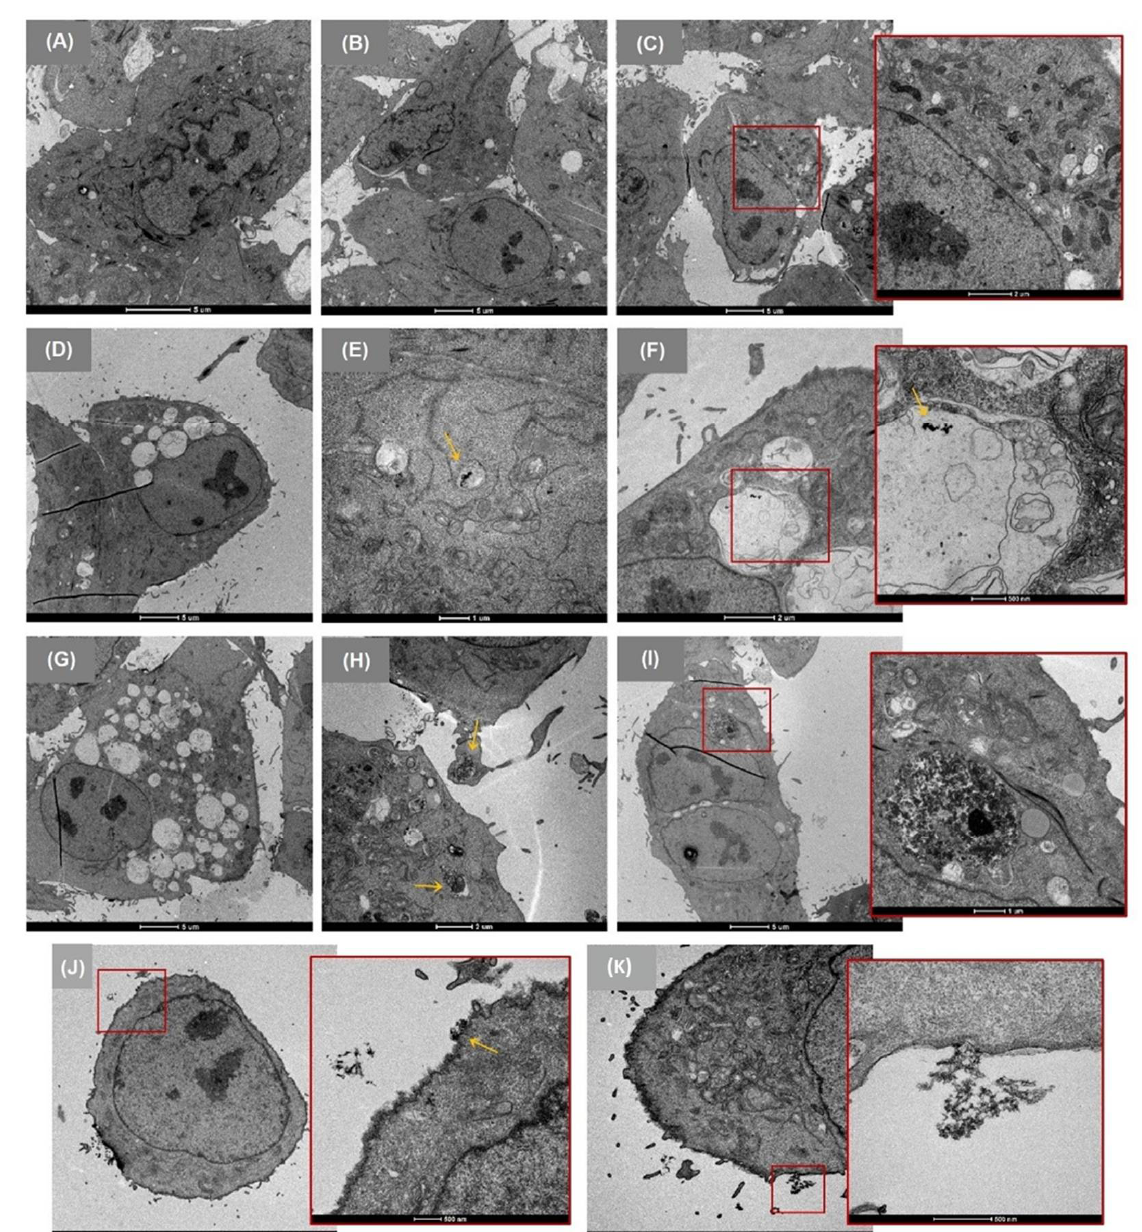
Figure 3. Representative TEM images of A549 cells after 24 h exposure to the CMNM under study (25 μg/cm 2 ). ( A – C ) Unexposed control cells; ( D – F ) CNF-TEMPO exposed cells; ( G – I ) CMF-ENZ exposed cells; ( J , K ) CNC exposed cells. Yellow arrows indicate the location of the CMNM uptake.